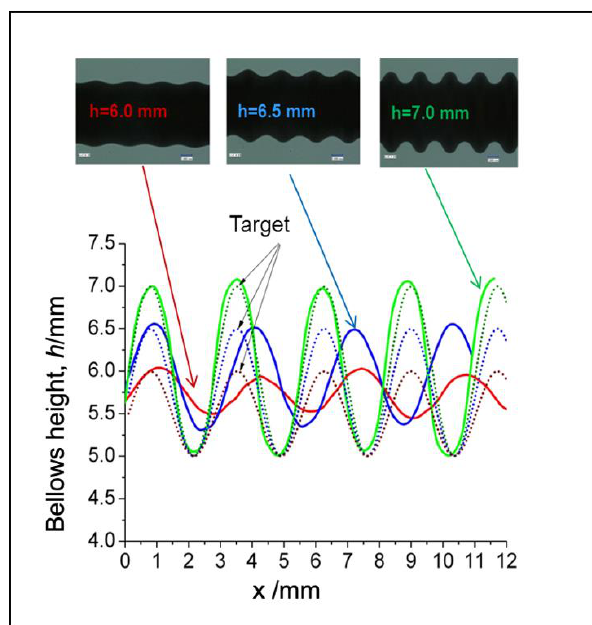
Figure 22. Bellows profile at various targets.